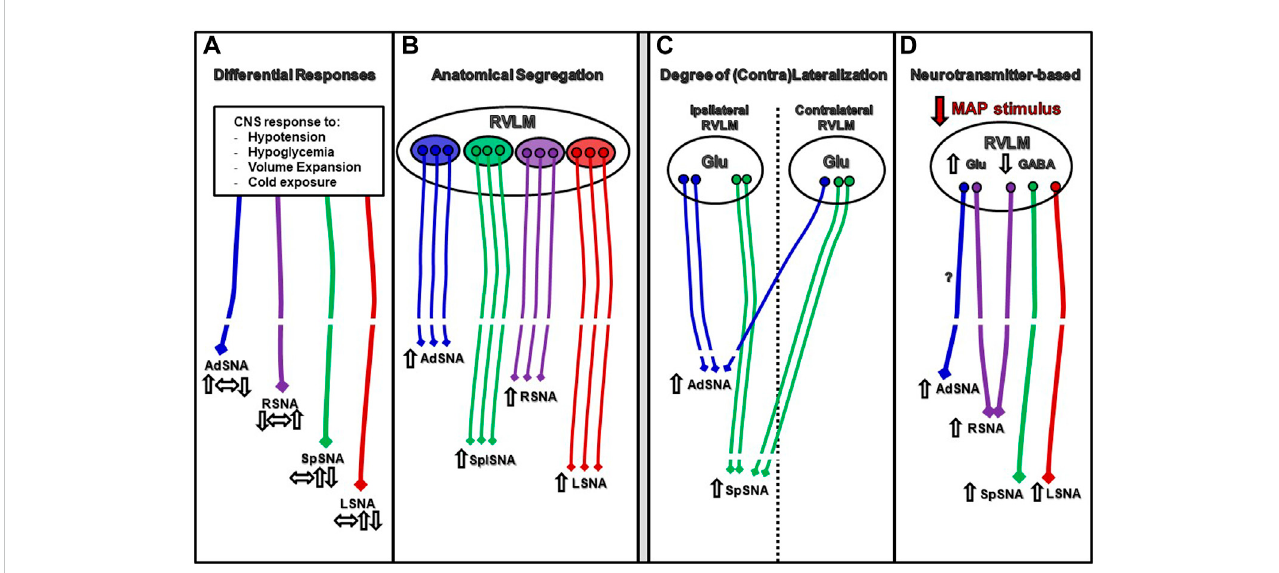
FIGURE 5 Schematic representations of some of the proposed mechanisms by which the RVLM regulates sympathetic out fl ow in a differential manner. Panel (A) Diverse physiological stimuli (i.e., hypoglycemia, volume expansion, etc. ref) trigger mechanisms within theCNS to elicit differential responses in sympathetic nerves of varying magnitude and direction. Panel (B) Individual neurons in RVLM subregions may exert control over individual nerves and be parcellated anatomically (McAllen et al., 1995; Sved et al., 2001). Panel (C) The bilateral structures of the RVLM have the capacity to control ipsilateral and bilateral nerve activity; however, there appears to be preferentially control of ipsilateral nerve activity in some cases (AdSNA) (Figure 2). Panel (D) Autonomic re fl exes like the barore fl ex may utilize different neurotransmitter systems to differentially regulate different vascular beds under conditions of hypotension (Figure 3; Mayorov and Head,